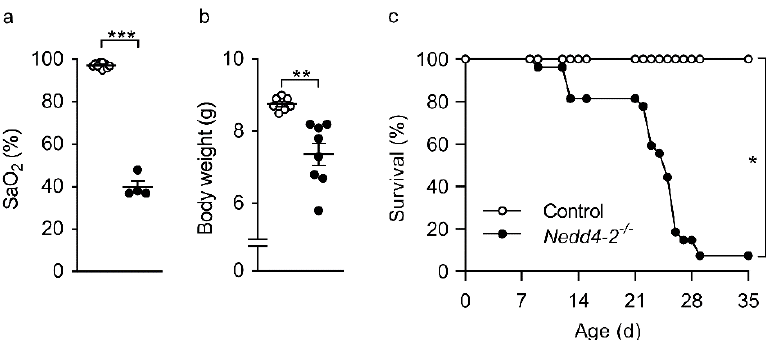
Figure 1 . Congenital deletion of Nedd4-2 in lung epithelial cells causes severe hypoxemia, failure to thrive and high mortality in neonatal mice: ( a , b ) Oxygen saturation ( a ) and body weight ( b ) measured in 3-week-old mice. n = 4–13 mice per group. ** p < 0.01, *** p < 0.001. ( c ) Survival curve of congenital Nedd4-2 −/− and control mice. n = 18–27 mice per group. * p < 0.05. Data are shown as mean ± S.E.M.